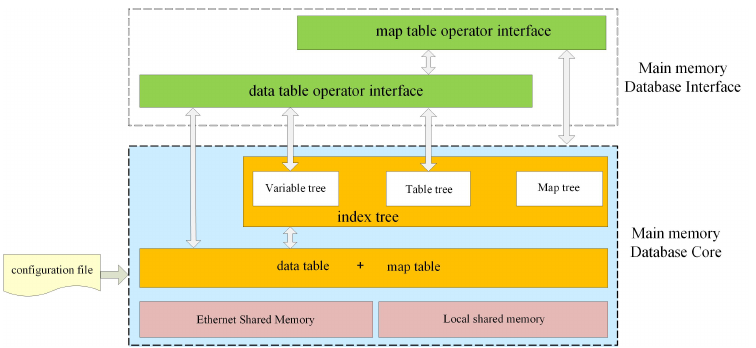
Figure 7. Main memory database